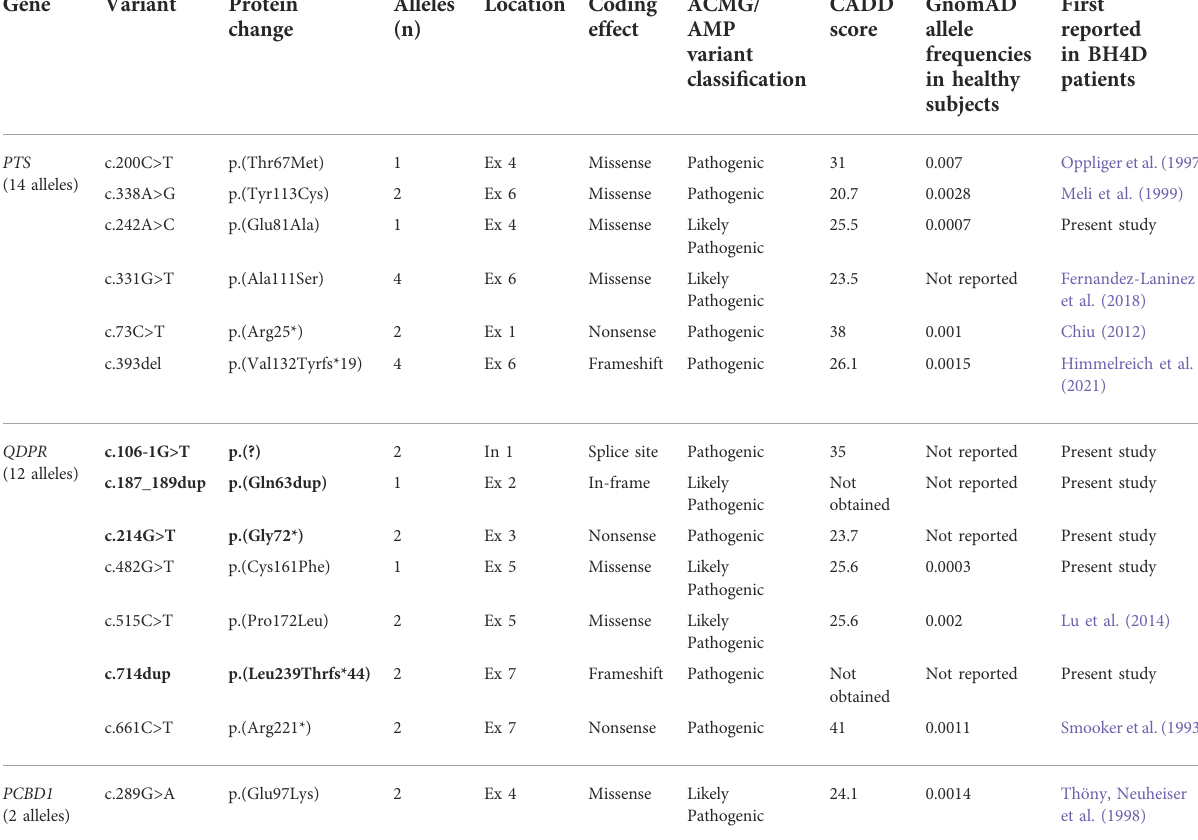
TABLE 3 Clinically relevant variants identi fi ed in Mexican HPA patients with suspected BH4 de fi